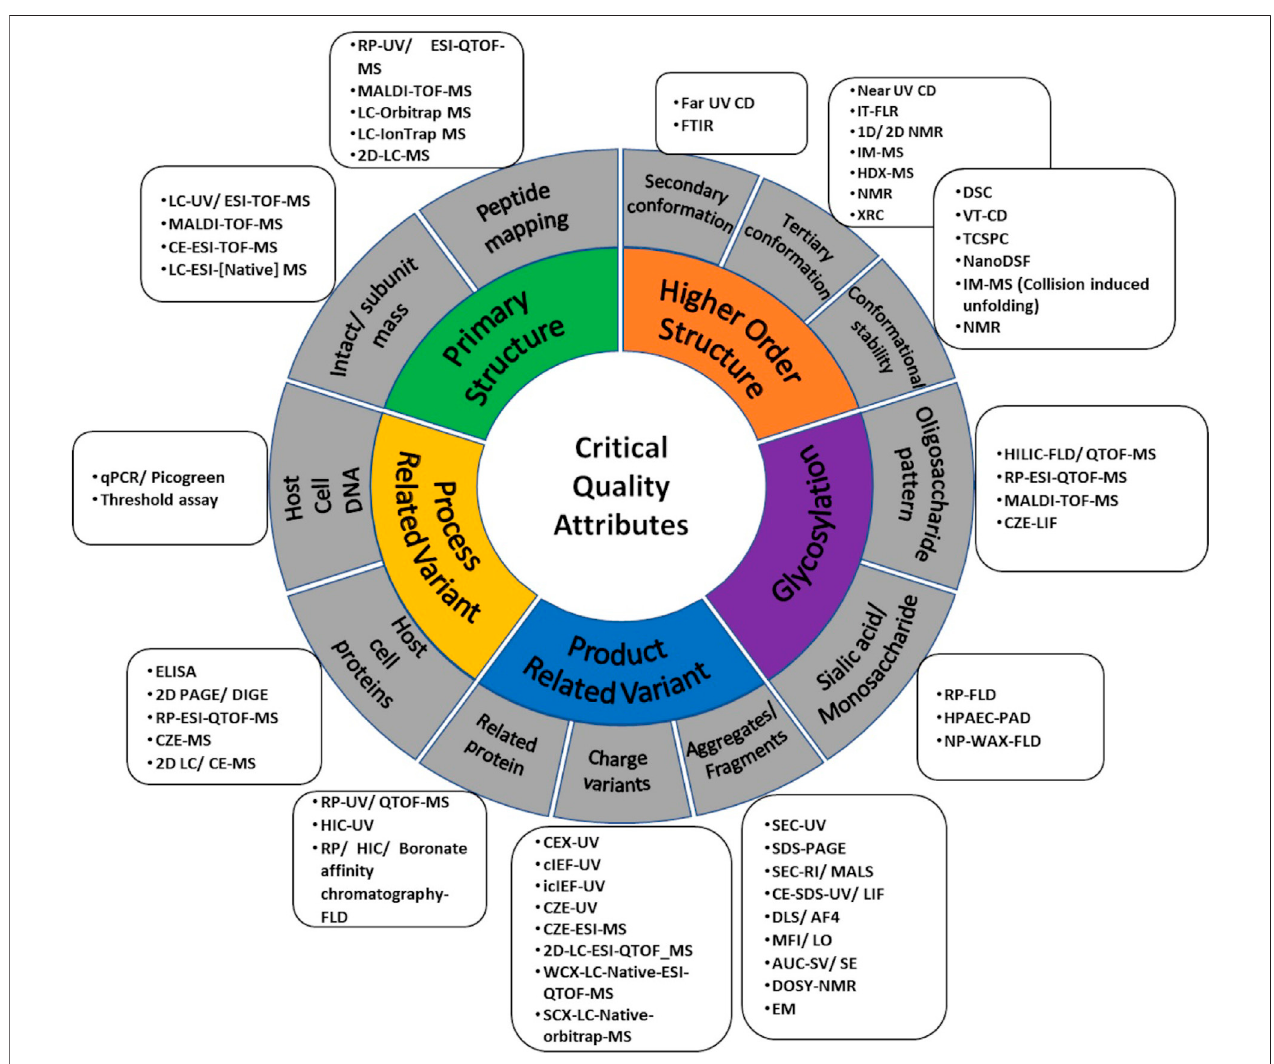
FIGURE 6 | A comprehensive map of orthogonal analytical platforms for different Critical Quality Attributes (CQAs) i.e., primary structure, Higher Order Structure (HOS), glycosylation, product-related and process-related variant used in analytical similarity assessment.